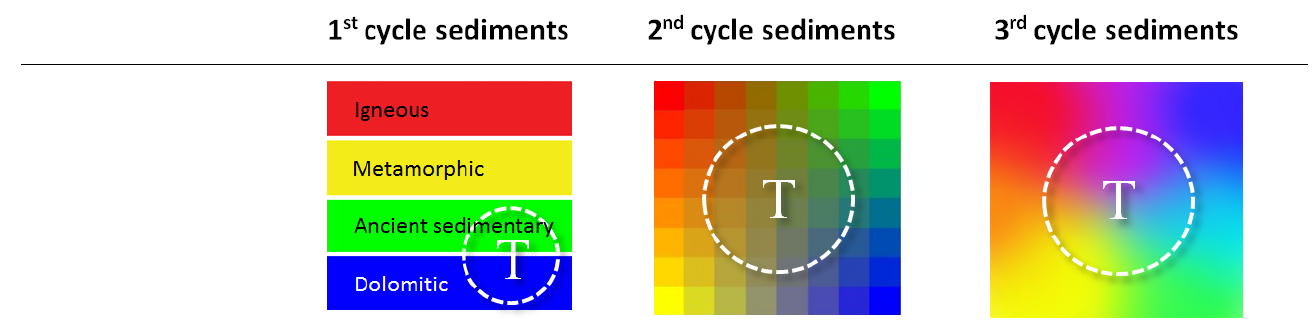
Figure 2. Conceptual illustration of Alpine soil sediments that increase in mineral and physical complexity as they are remixed in successive sedimentary phases typical of local event stratigraphy. First-cycle sediments have a close connection and proximity to the parent rock. Second-cycle sediments are composed of first-cycle materials (eroded and retransported away from the first deposition place) mixed with new first-cycle materials. Third-cycle sediments are formed by geomorphological processes that eroded and resedimented first- and second-cycle sediments. The geomineral and textural complexity becomes progressively more intense and it is difficult to recognise any parent rocks.